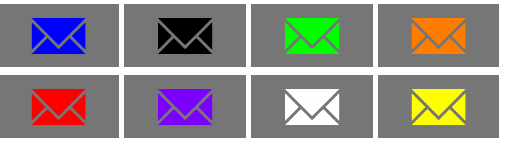
Figure 3. Example test images used in the experiment. In the figure, the images were composed from a “gray” color set as primary for the background, and the remaining colors (blue, grey, green, orange, red, violet, white, and yellow) were set as secondary colors.